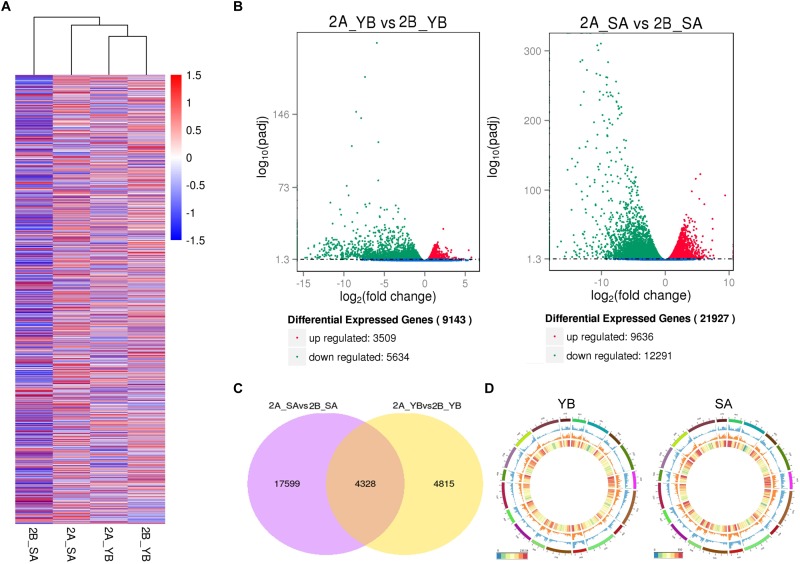
Statistical analysis of gene expression detected by transcriptomic analysis. (A) Heatmap analysis of all DEGs at the different stages. (B) Volcano plot of up- and down-regulated genes at the YB and SA stages. (C) Venn diagram showing common DEGs at the two stages. (D) Circle plot of the distribution of SNPs and indels, and the density of DEGs in different chromosomal regions. The outermost layer represents all B. napus chromosomes (A01–A10 and C01–C09). The blue layer represents the distribution of SNPs, the middle orange layer shows the distribution of indels, and the innermost layer indicates the density of DEGs.